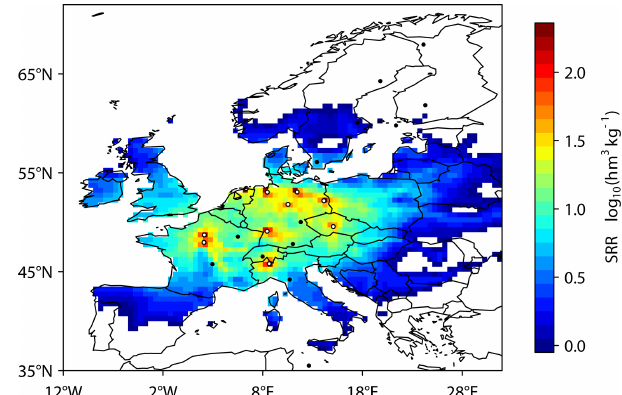
Figure 4. Map of the total mean SRR for optimal sites for monitor- ing fossil fuel CO 2 emissions with monthly resolution and including existing information from CO 2 mixing ratios. The locations of the optimal sites are indicated by the white points (i.e. SAC, KIT, LUT, KRE, STE, LIN, GAT, IPR, TRN, and TOH), and the locations of the unselected sites are indicated by the black points.